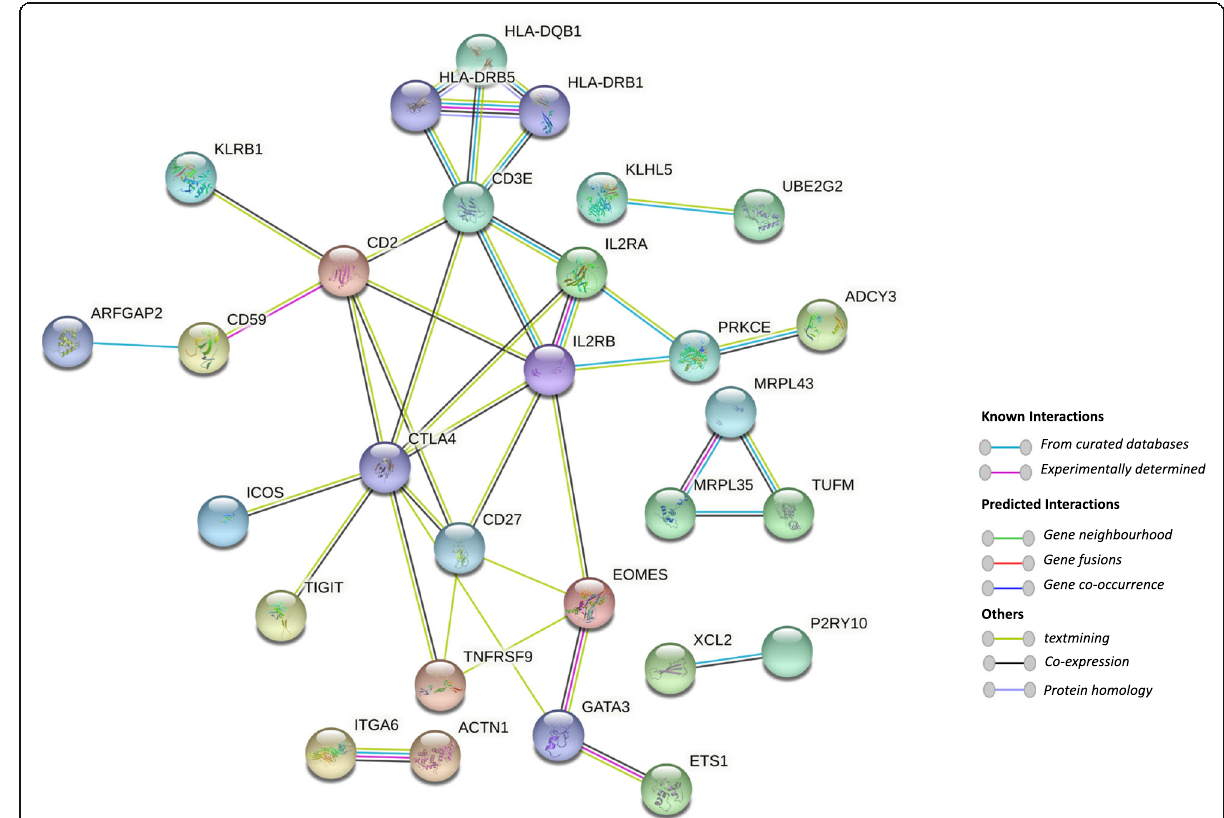
Fig. 6 High-confidence protein-protein interactions of the significantly differentially expressed genes. Disconnected network nodes are not